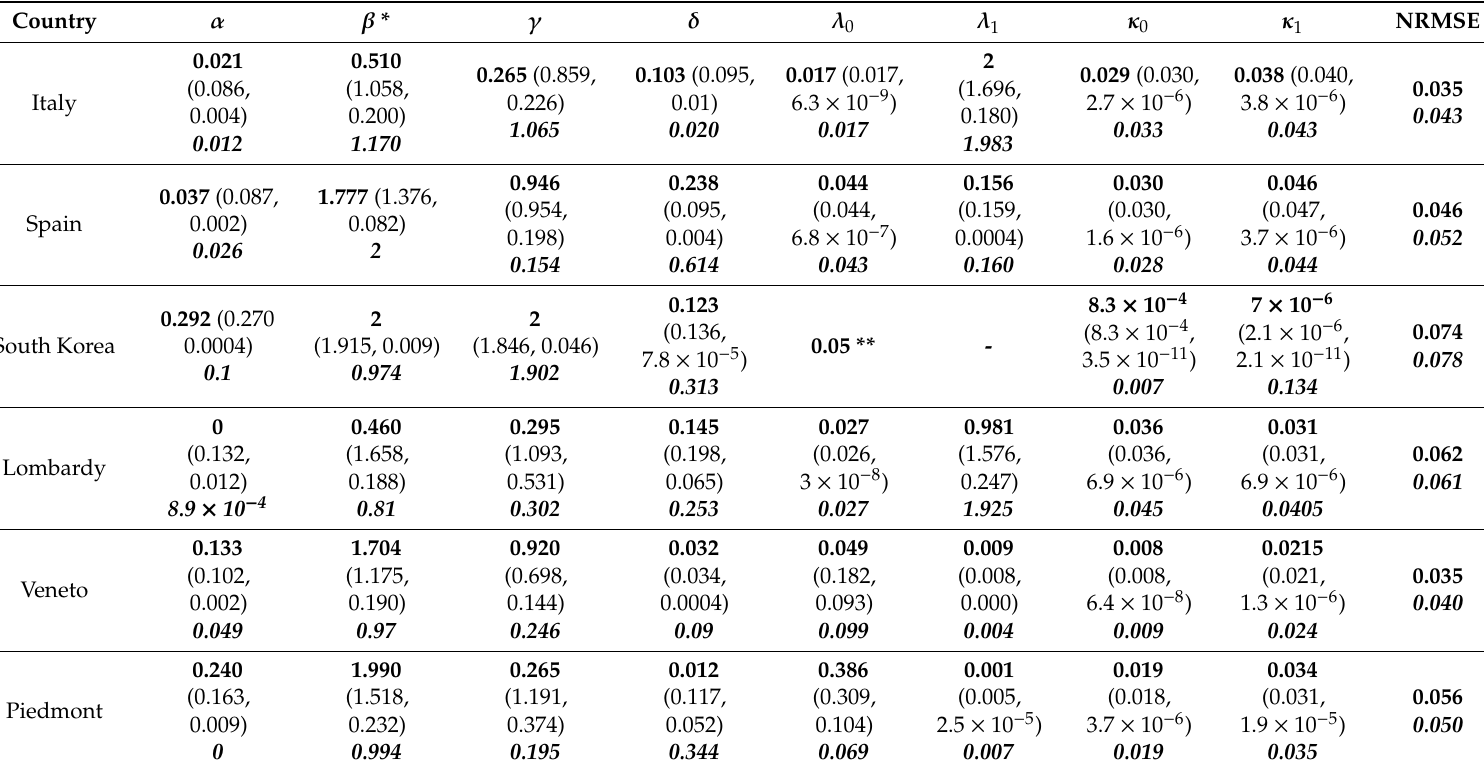
Table 3. Coe ffi cients of the PSO best-solutions and deterministic solutions; bold refers to the best solution of the PSO approach (mean and variance on brackets), italic-bold refers to the solution given by the deterministic